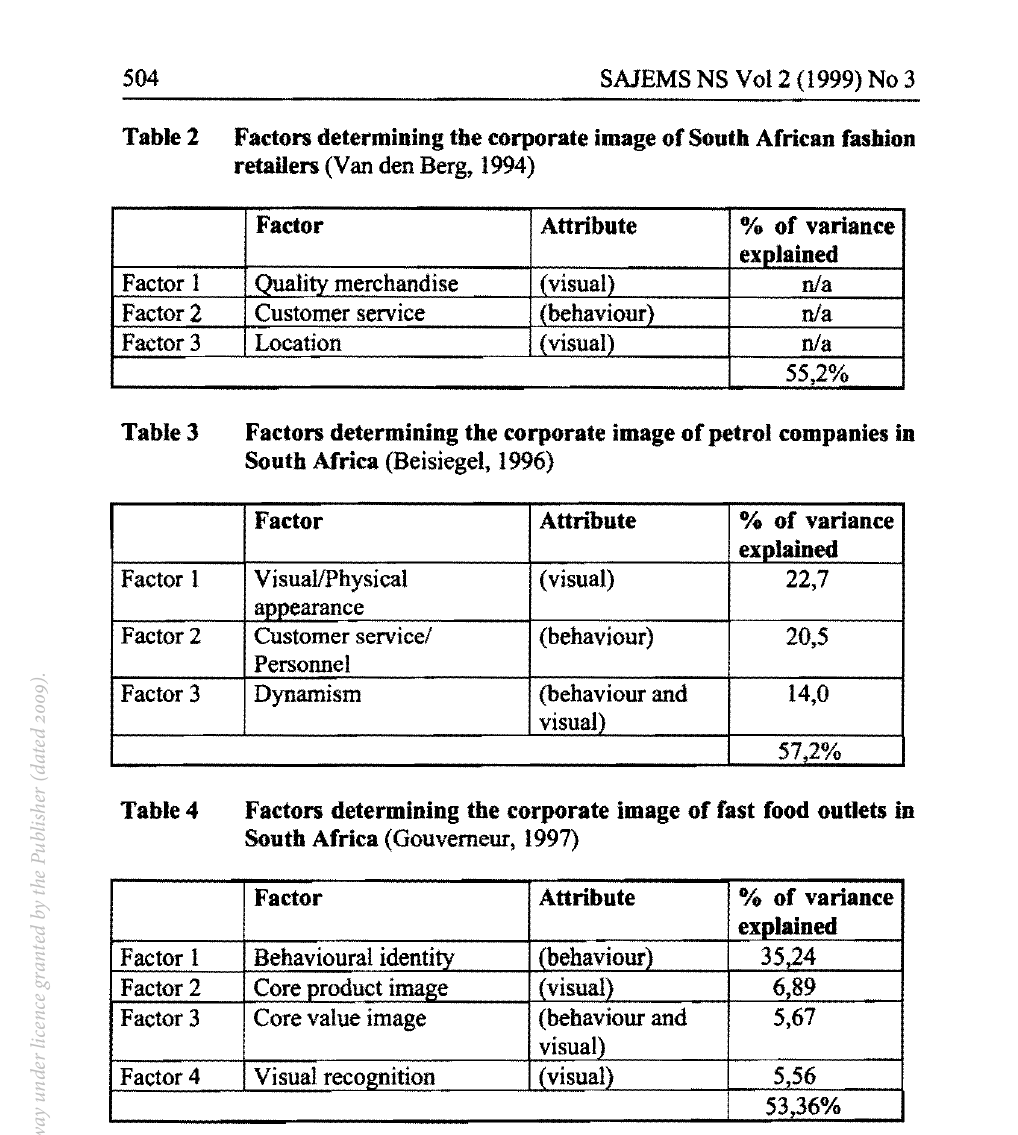
Factors determining the corporate image of fast food outlets